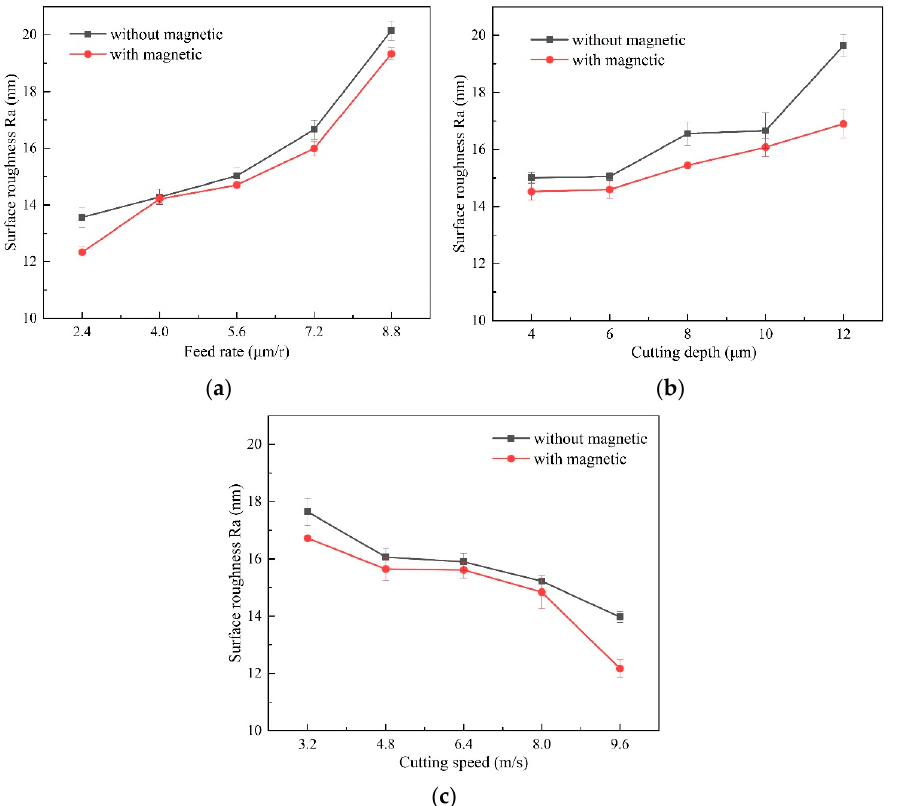
Figure 11. Effect of magnetic-field-assisted turning on surface finish, ( a ) surface roughness varying with feed rate, ( b ) surface roughness varying with depth of cut, ( c ) surface roughness varying with cutting speed.